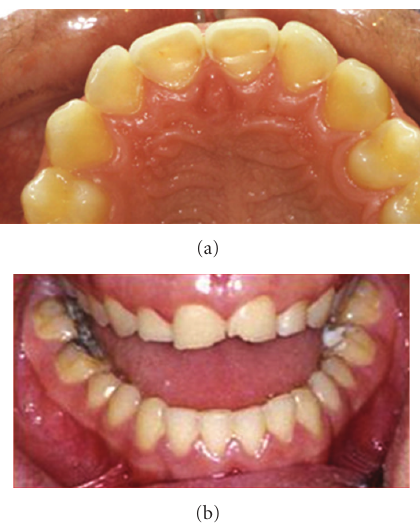
Figure 2: Localized tooth wear of a 15 year